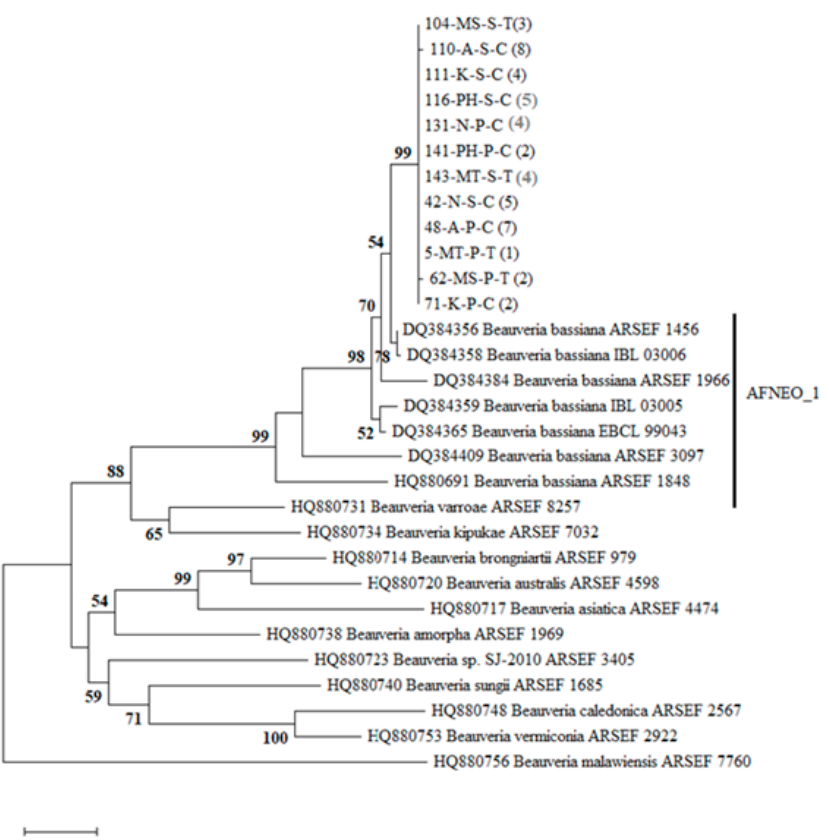
Figure 2. Phylogenetic tree of Beauveria indicating the position of Malawian isolates collected from sugarcane fields within the worldwide Beauveria genetic structure. The tree was inferred by the maximum likelihood (ML) method based on the Kimura 2-parameter model with a discrete Gamma distribution (K2 + G) using the Kimura 2-parameter method of intergenic Bloc region of 47 Malawian and 18 reference sequences from GenBank (given with their associated accession number). For the isolates from Malawi, the code after the isolate number denotes substrate: S = soil, P = plant; location: MS = Maseya, MT = Mitole, N = Nchalo, P = Phata, K = Kasinthula, A = Alumenda; in brackets = number of isolates. Branch support was measured through 1000 bootstrap